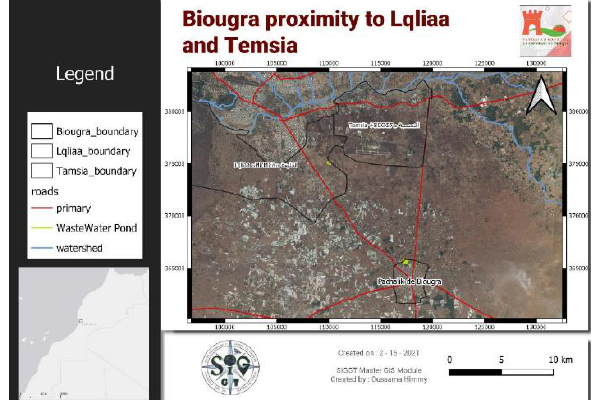
Figure 8 . Biougra city proximity to Lqliaa city and Souss River